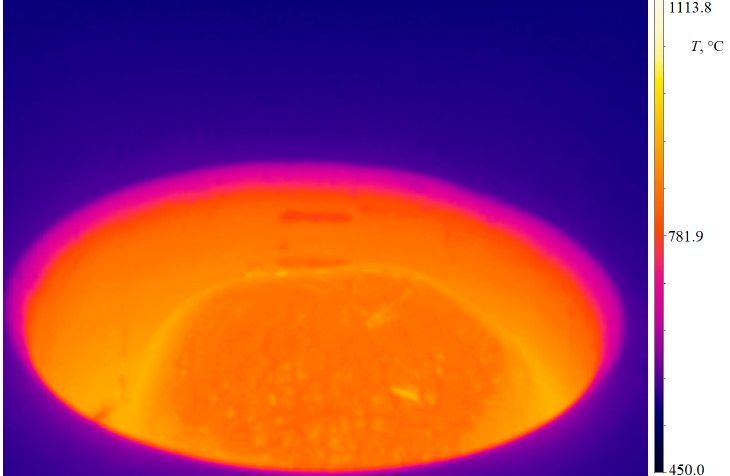
Figure 7. Images of the surface of aluminium melted in the ISM furnace. Table 4 summarises the values of the meniscus surface area estimated for all experiments using the proposed calculation method. Table 4. Values of the surface area of meniscus formed for Al-Zn alloys, estimated with the use of the proposed calculation method. No. 92.4 The values of the zinc overall mass transfer coefficient k Zn , determined based on Equation (7), are presented in Tables 5 and 6. Figures 8 and 9 show a graphic interpretation of changes in the coefficient k Zn values versus the operating pressure of the crucible induction furnace. Table 5. The overall mass transfer coefficient k Zn as well as the coefficients β l Zn and k e Zn (crucible induction furnace). T , K